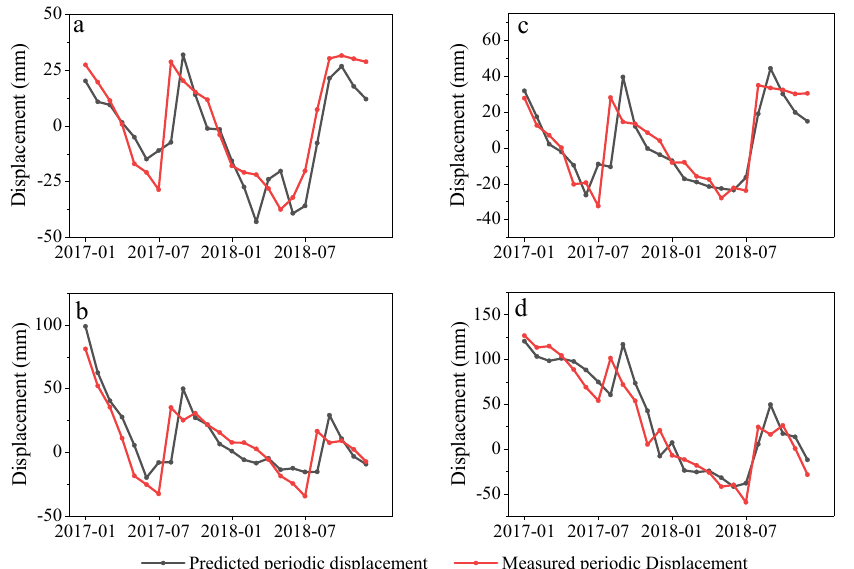
Figure 10. ( a ) The TCN prediction of periodic displacement in ZG323; ( b ) the TCN prediction of periodic displacement in ZG324; ( c ) the TCN prediction of periodic displacement in ZG325; ( d ) the TCN prediction of periodic displacement in ZG326.